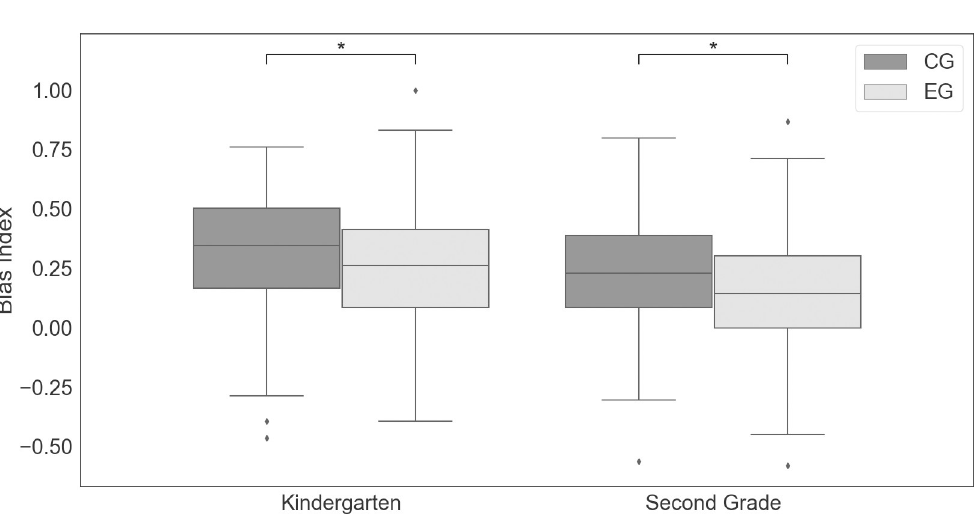
Fig 2. Distribution of the bias index separated for condition and age. Note. Boxplot for the dependent variable bias index, separated for Age (Kindergartners vs. Second Graders), and Condition (Control Group (CG) vs. Experimental Group (EG)). Whiskers represent 1.5 � interquartile